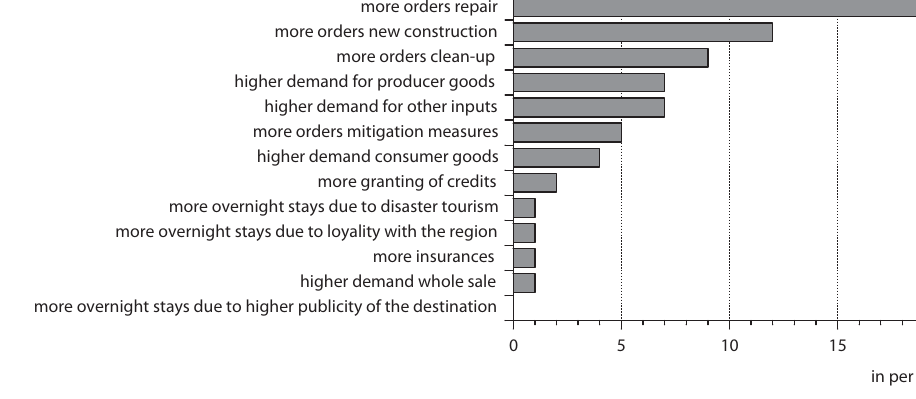
Fig. 7. Companies’ estimates of triggers of rising revenues, multiple responses, n = 70.